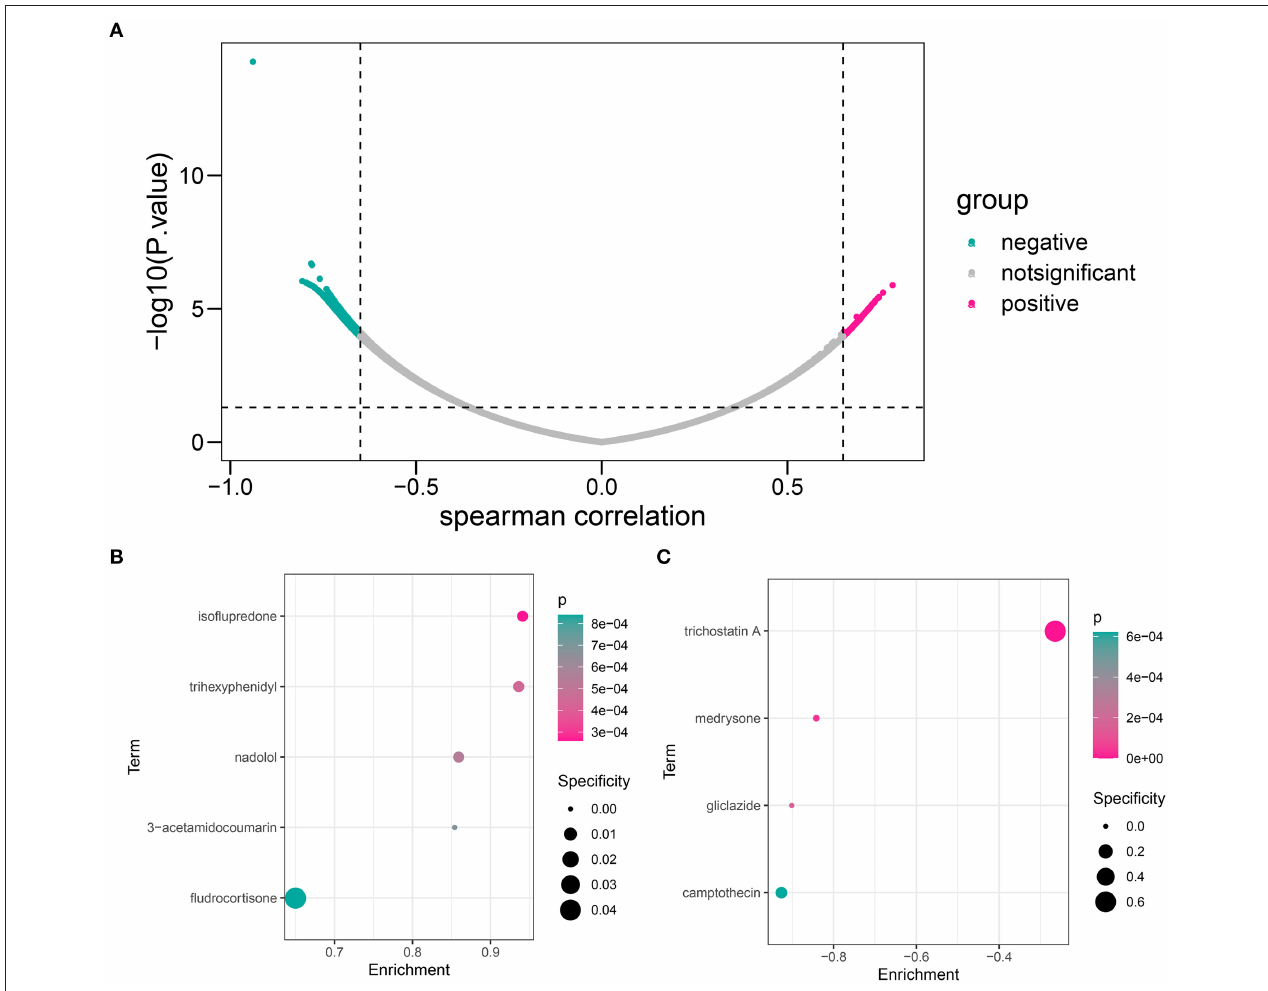
FIGURE 11 | The candidate compound targeting the HOXB4–AKR1C3 axis. (A) Volcano map showing that a total of 536 genes, including 136 positively correlated and 400 negatively correlated, were associated with a logical score. (B) The compounds which might target the positively correlated genes. (C) The compounds which might target the negatively correlated